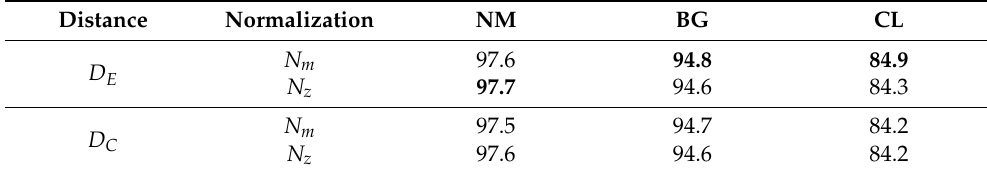
Table 7. Ablation experiments for Metric-based Frame Attention Mechanism. Control condition: the different data normalization methods and different distance metric strategies. D E and D C : represent the Euclidean distance and cosine similarity, respectively. N m and N z : represent the max-min normalized and Z-score normalized, respectively. Distance